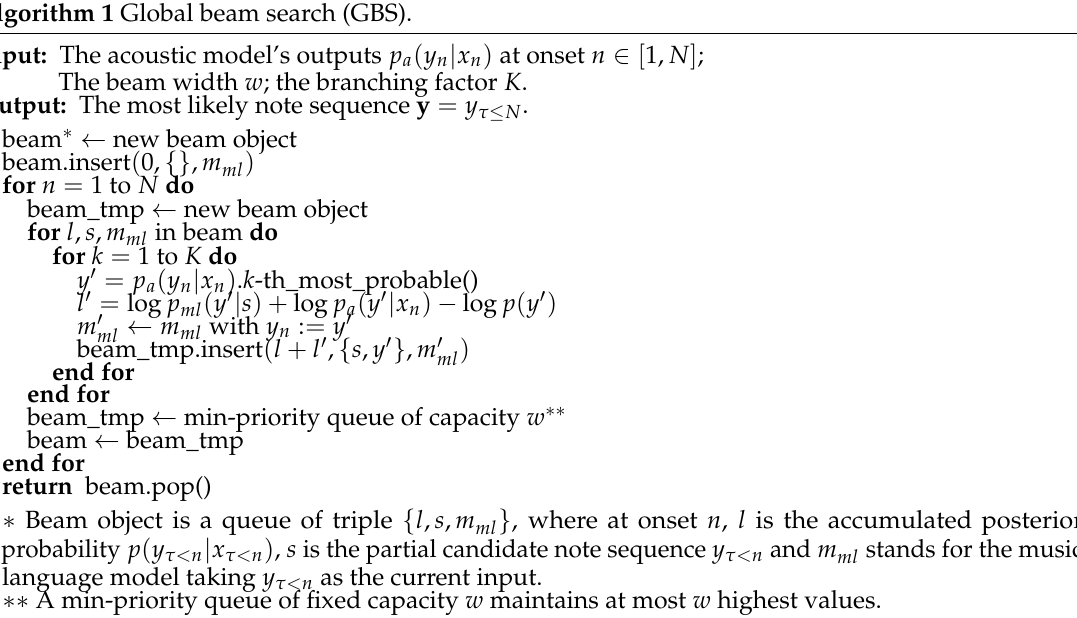
Algorithm 1 Global beam search